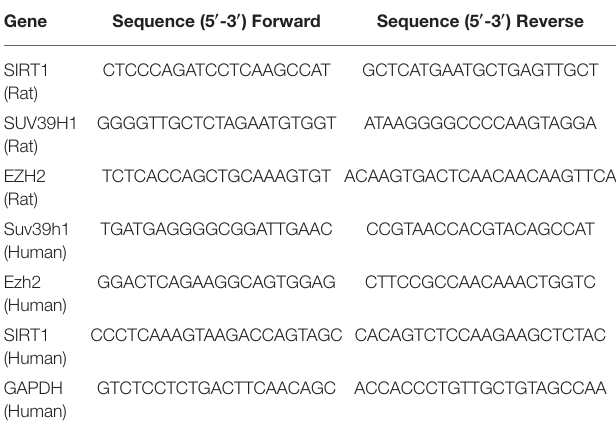
TABLE 1 | Primer set used for genes expression analysis. Gene Sequence (5 ′ -3 ′ )